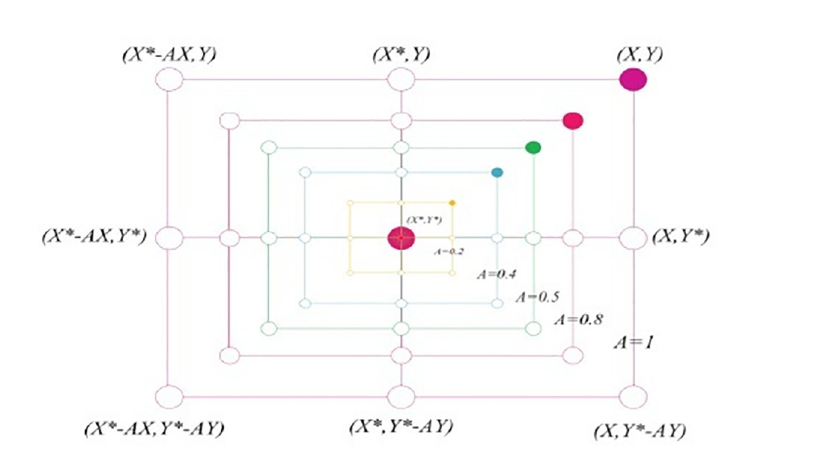
Fig 5. Shrinking encircling mechanism in bubble-net search